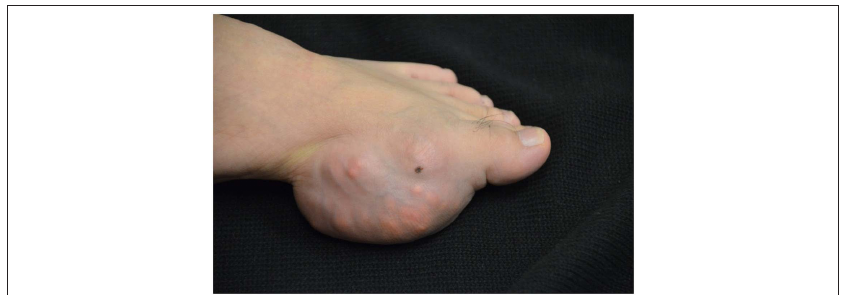
Figure 1 | Severe feet deformities and tophi